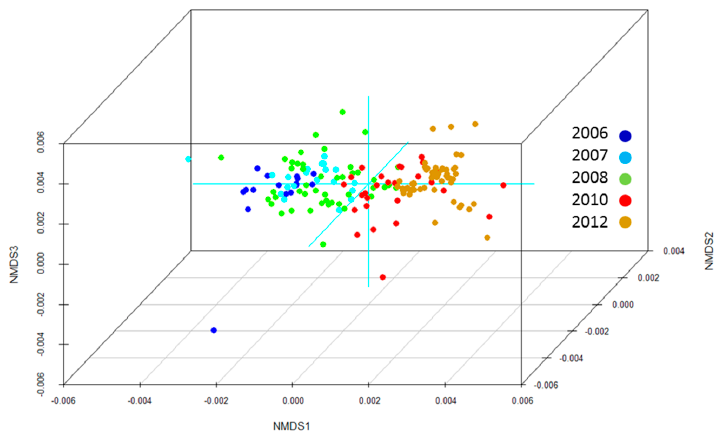
Figure 2. Multivariate, nonparametric, multi ‐ dimensional scaling (NMDS) of gene transcription profiles (see Table 2) of sea otters captured in five different years (2006, 2007, 2008, 2010, 2012) in western Prince William Sound, Alaska, showing distinct separation of 2006–2008 samples from the 2010 and 2012 samples.